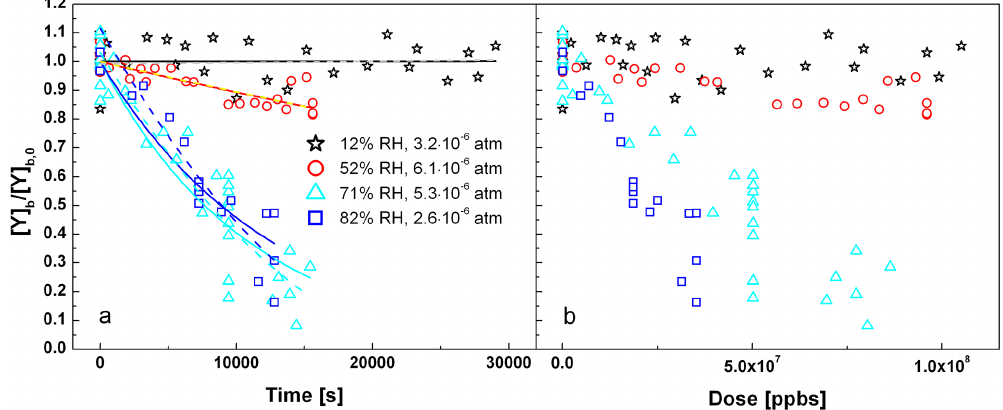
Figure 3. (a) Depletion of shikimic acid as a function of exposure time via the decrease in the normalized OD at 284.4eV (relative loss). The depletion was measured at four different relative humidities. The lines show the respective fits for that humidity assuming pseudo-first- order decay (black, red, blue and cyan, solid line) and reacto-diffusive limitation (grey, yellow, blue and cyan, dashed line). (b) Depletion of shikimic acid as a function of O 3 dose via the decrease in the normalized OD at 284.4eV at four different relative